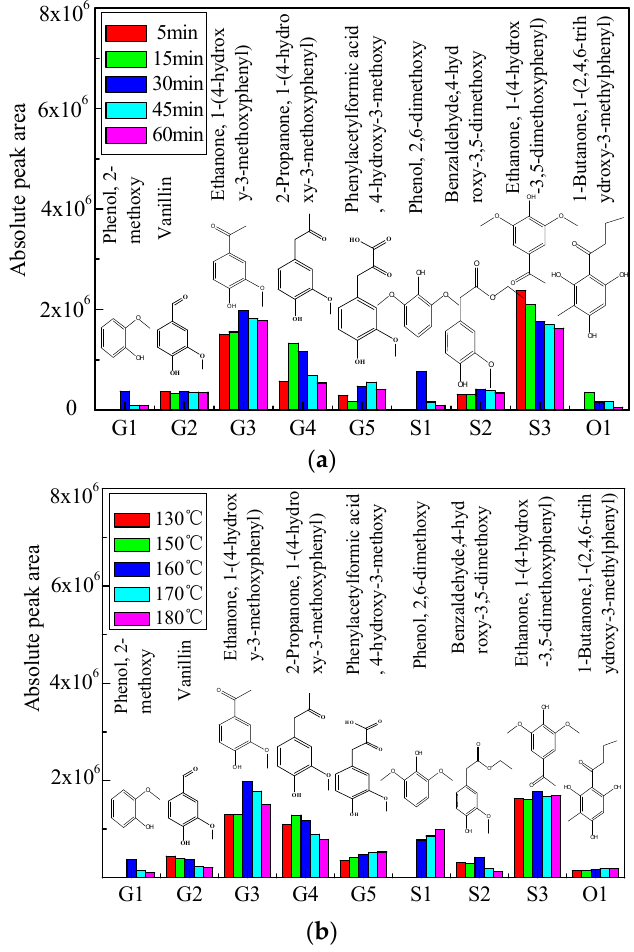
Figure 2. ( a ) Distribution of aromatic monomers in bio-oil 1 for different reaction times under 160 ◦ C; ( b ) Distribution of aromatic monomers in bio-oil 1 for different reaction temperatures at 30 min. Comparatively, the yield of Ethanone, 1-(4-hydrox-3,5-dimethoxyphenyl) (S3), and 1-Butanone, 1-(2,4,6-trihydroxy-3-methylphenyl) (O1) is not notably influenced by reaction temperature at 30 min (Figure 2b). Phenol, 2-dimethoxy (G1) and ethanone, 1-(4-hydroxy-3-methoxyphenyl) (G3) and benzaldehyde, 4-hydroxy-3,5-dimethoxy (S2) achieved their maxima under 160 ◦ C, while 2-propanone, 1-(4-hydroxy-3-methoxyphenyl) (G4) reached the highest production under 150 ◦ C. The yield of phenylacetylformic acid, 4-hydroxy-3-methoxy (G5) was increased with the reaction temperature due to the enhancement of the reaction between the side-chain on the primary fragments and formic